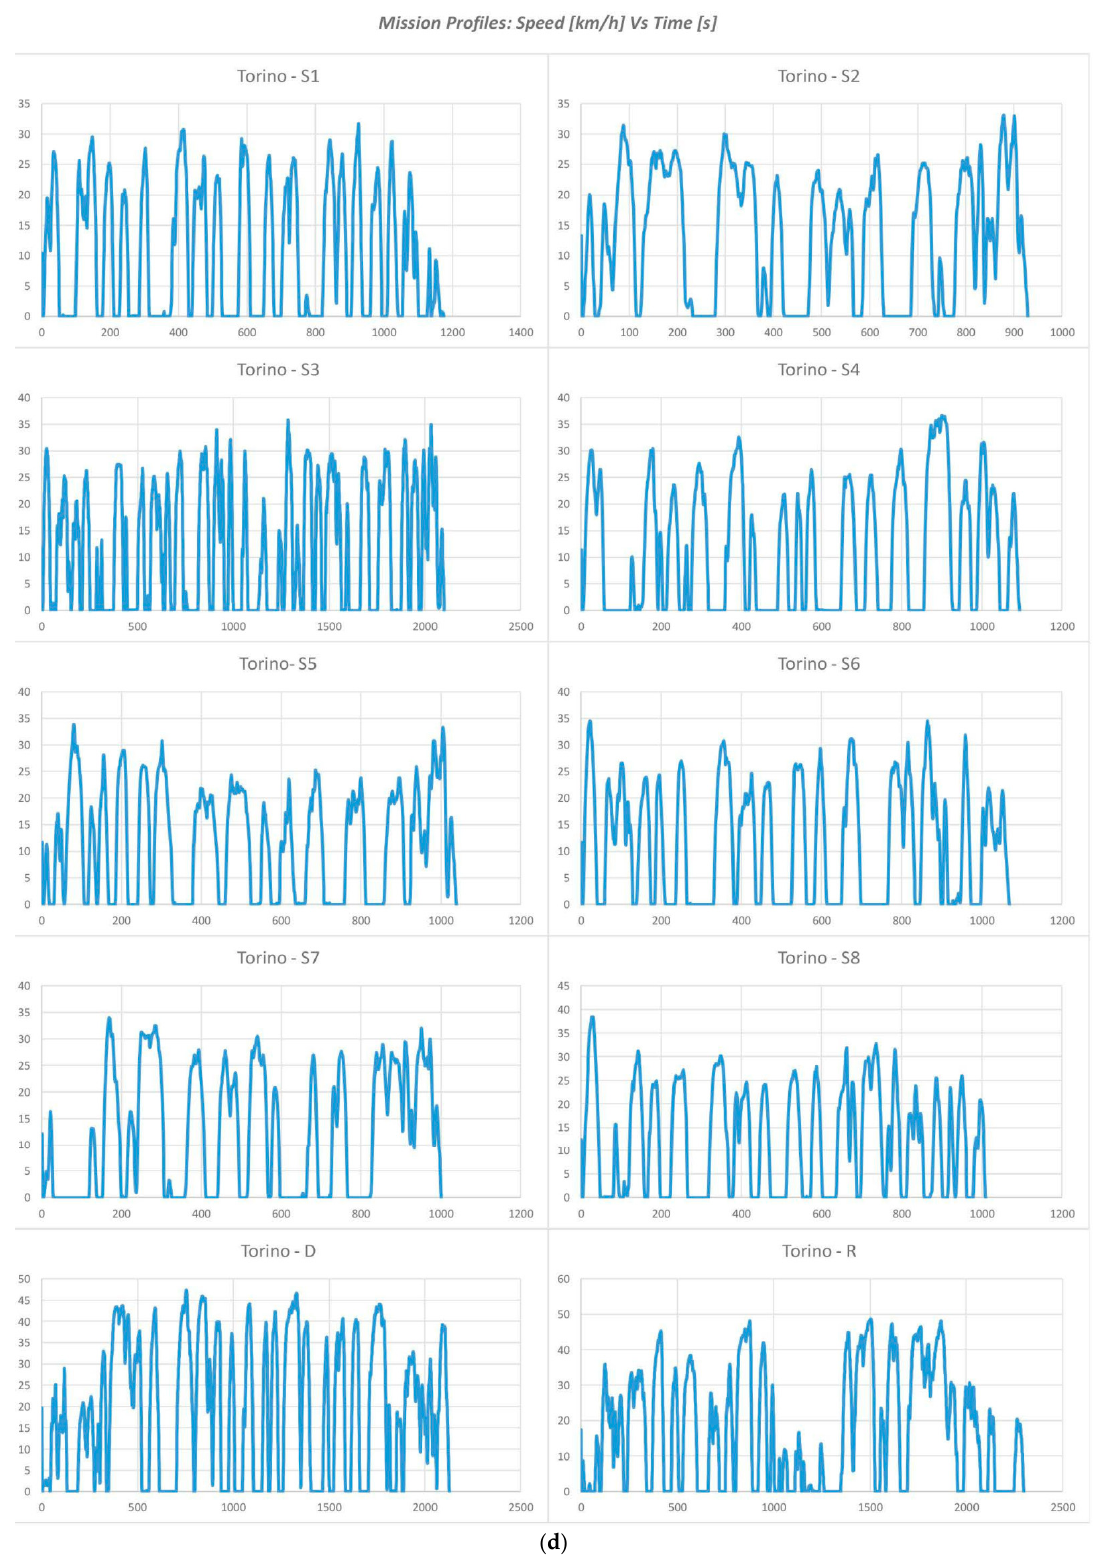
Figure 1. ( a ) NYB (“New York Bus”) and BUS RTE (bus mission measured in Denver-USA) mission profiles, ( b ) “Bologna” mission profiles, ( c ) “Ravenna” mission profiles and ( d ) “Torino” mission profiles.